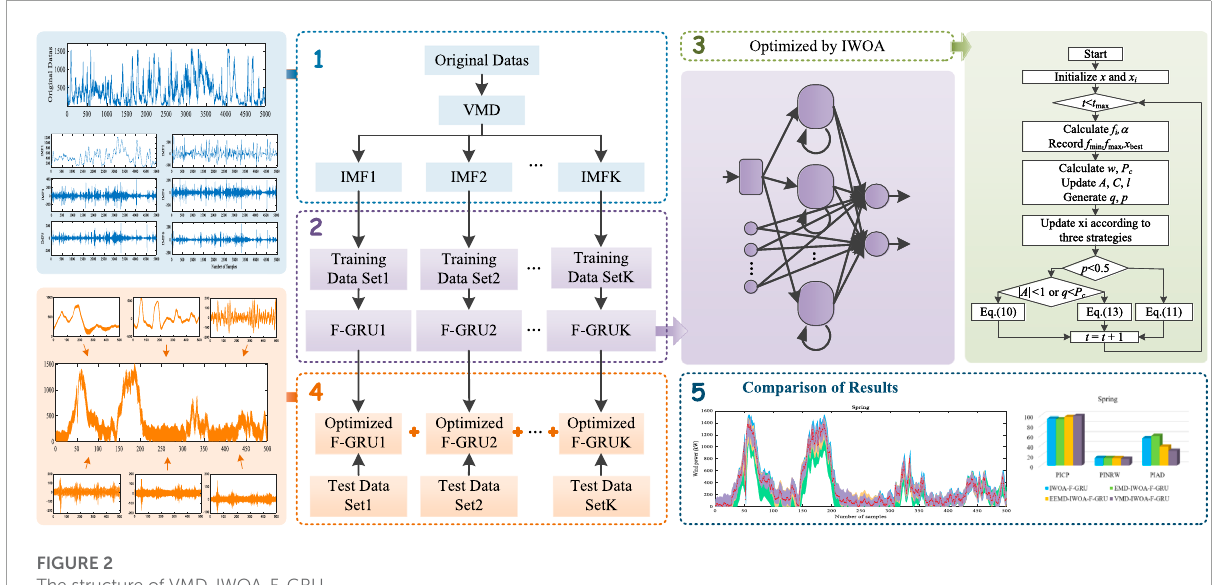
FIGURE 2 The structure of